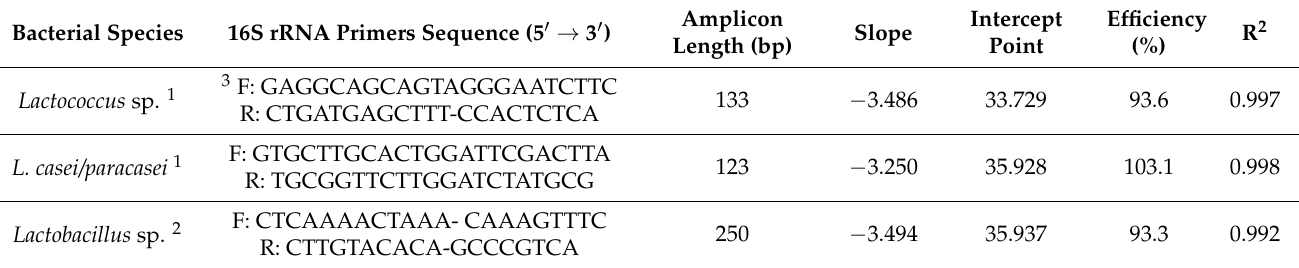
Table 1. qPCR primers and standard curve results for 16S rRNA gene quantification of Cheddar cheese